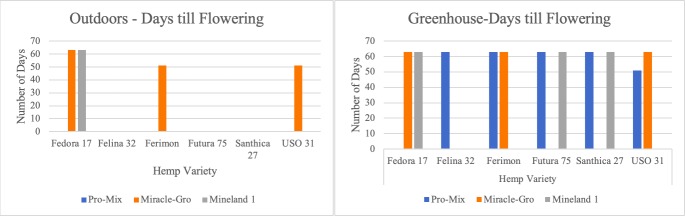
Days to flowering.